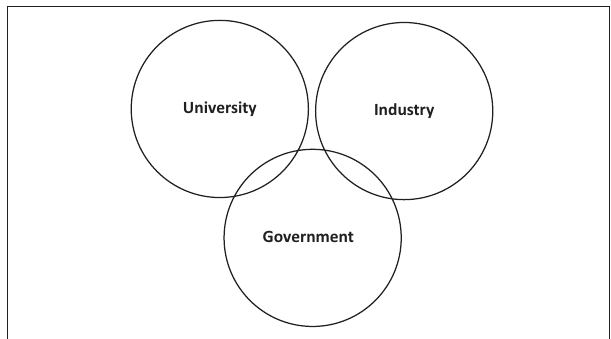
FIGURE 1: The triple helix